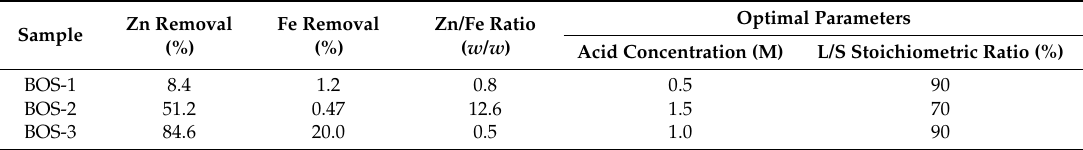
Table 3. The optimal conditions and the corresponding leaching efficiencies of the three BOS filter cakes. Zn Removal Sample